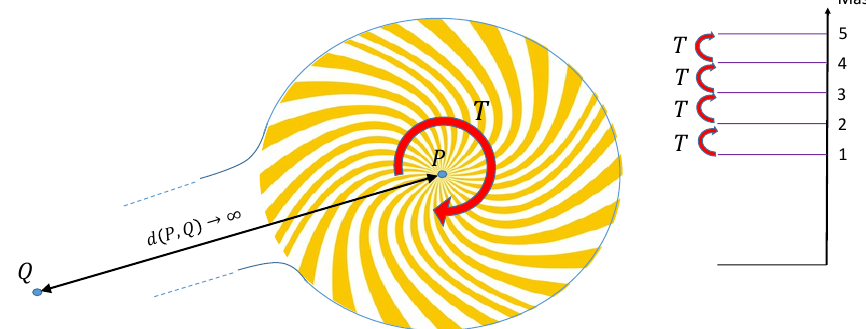
Figure 1 . Figure illustrating the relation between the distance conjecture and monodromy. The point P is at in(cid:12)nite distance and the monodromy about it is denoted by T. The monodromy determines the local singular geometry of the moduli space, which leads to the exponential behaviour of the mass of the tower of states. The monodromy also acts on the spectrum of states picking out a speci(cid:12)c in(cid:12)nite set of